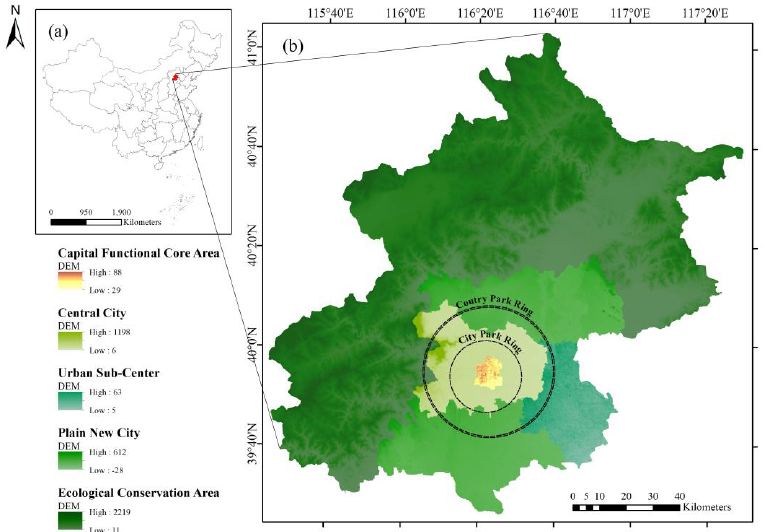
Figure 2. Location of the study area in China (a) and the plan for UGS construction of Beijing